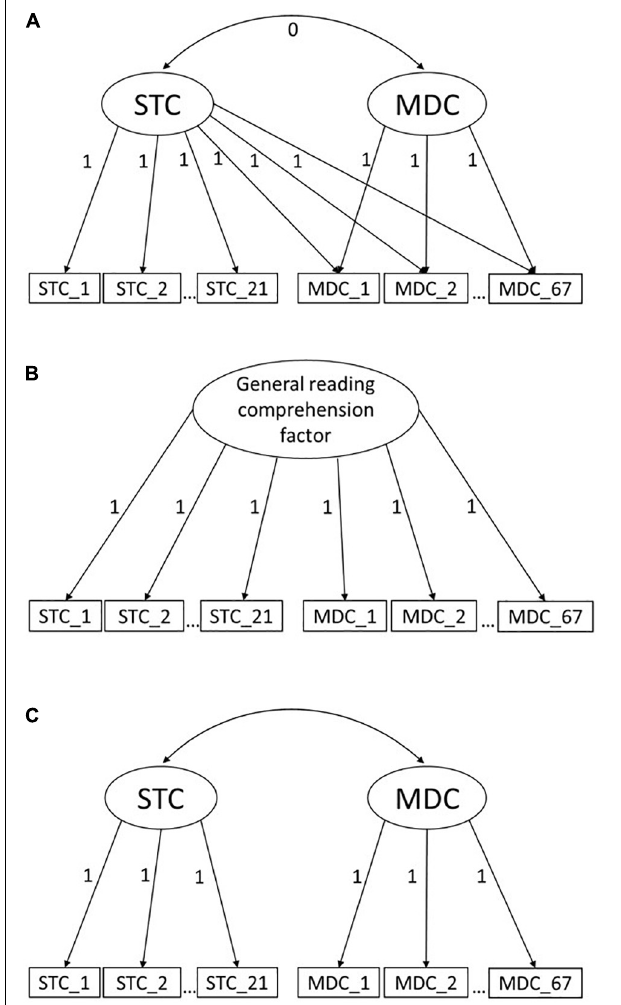
FIGURE 1 | Different approaches for modeling the relation between single text and multiple document comprehension. (A) Add-on model, (B) Unidimensional model, (C) Two-factor